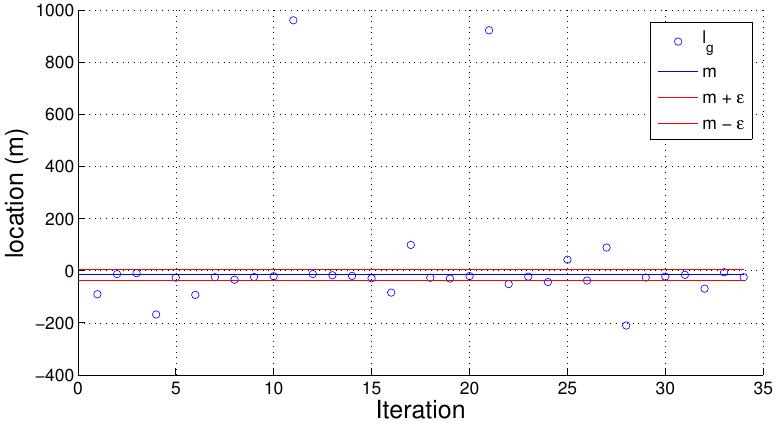
Figure 6. x-coordinates (cid:126) x i for device i , with mean ω and bounds (cid:101) . (cid:101) =